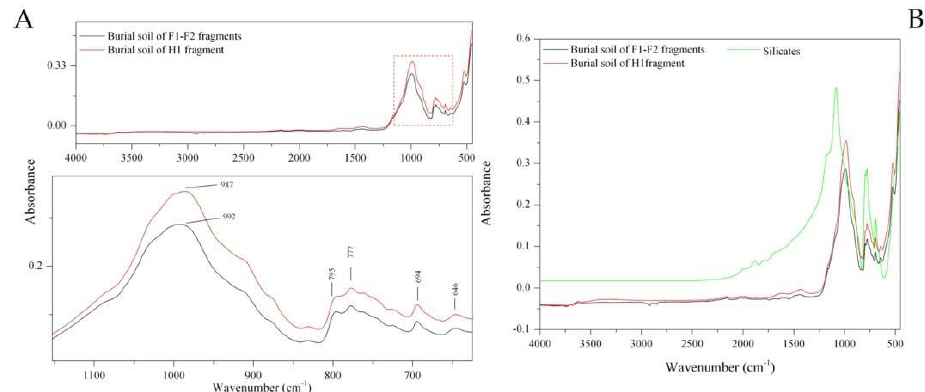
Figure 7. ( A ) IR spectra of the two burial soils compared with silicate absorption bands ( B